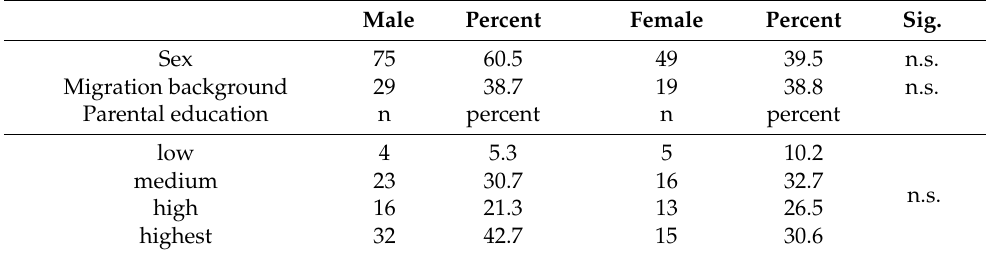
Table 1. Sociodemographic characteristics of age group sample 4 years 0 months–6 years 11